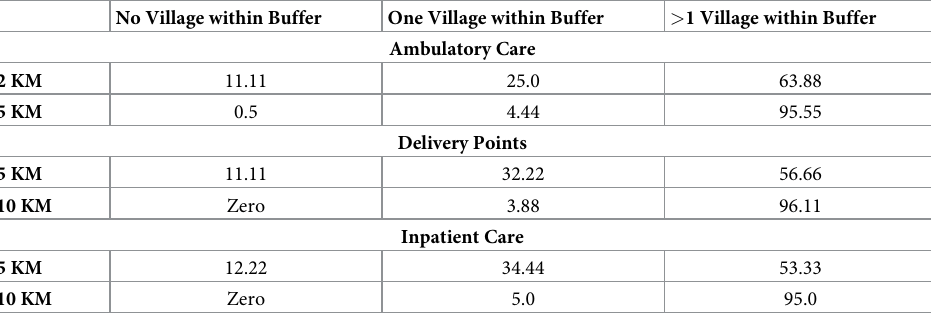
Table 2. Results for proximity analysis: Percentage of villages within distance